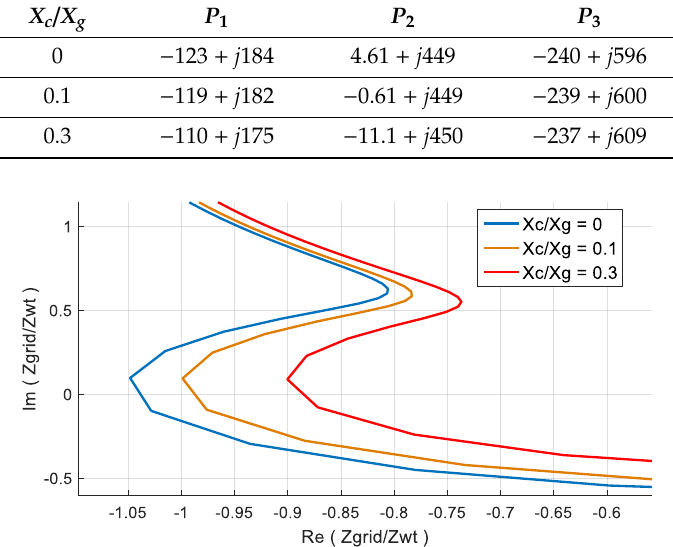
Figure 11. Nyquist criteria under X c /X g variations for SCR = 1.25 and X/R = 206.1.4. Time-domain simulation result.